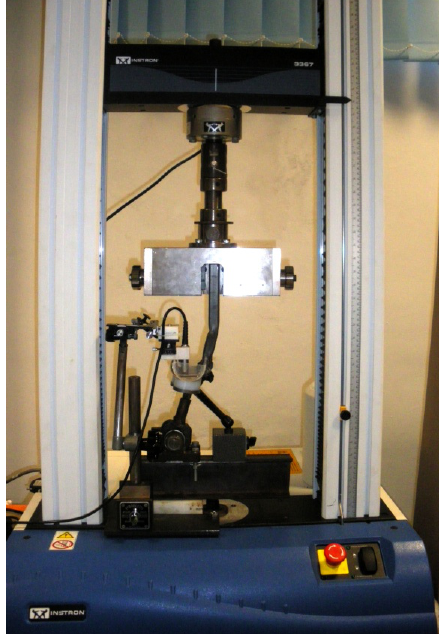
Figura 11: Protesi montata sulla macchina prova materiali. Figure 11: Knee prosthesis installed in the material testing